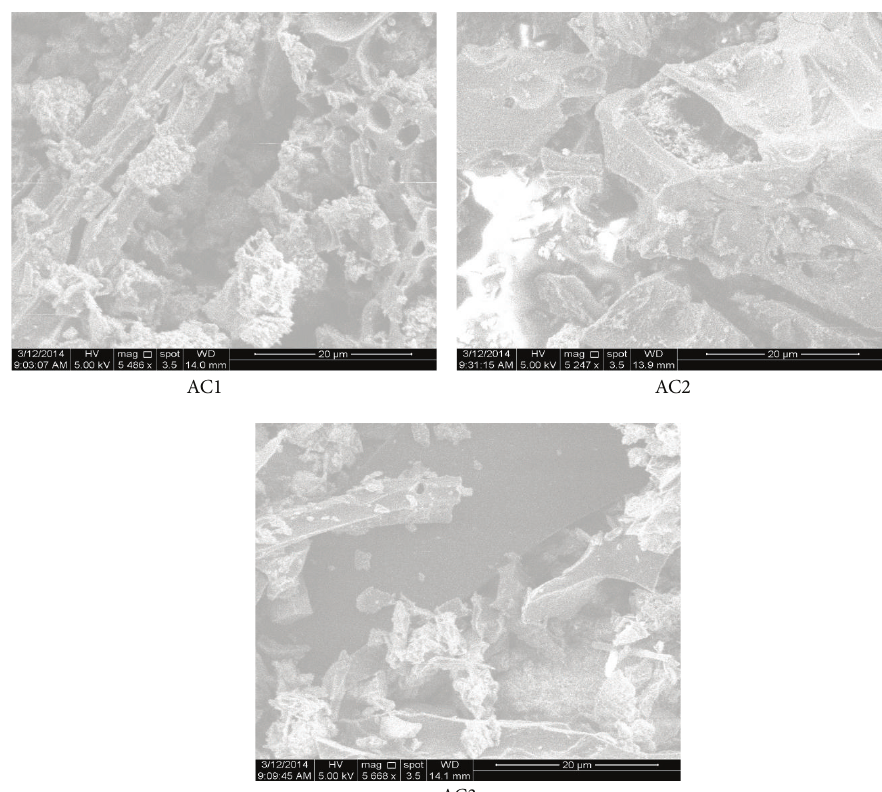
Figure 7: SEM images for the AC1, AC2, and AC3 samples synthesized from IKDP.